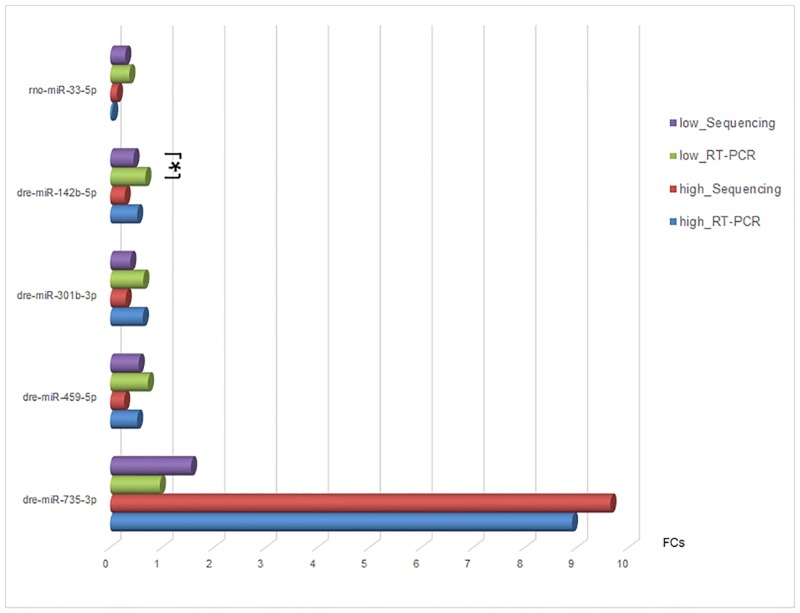
The quantitative miRNA expressions using sequencing and RT-PCR.The asterisk indicated only for dre-miR-142b-5p in low concentration BDE47 treatment, the result of statistical significance by RT-PCR determination was inconsistent with miRNA sequencing.